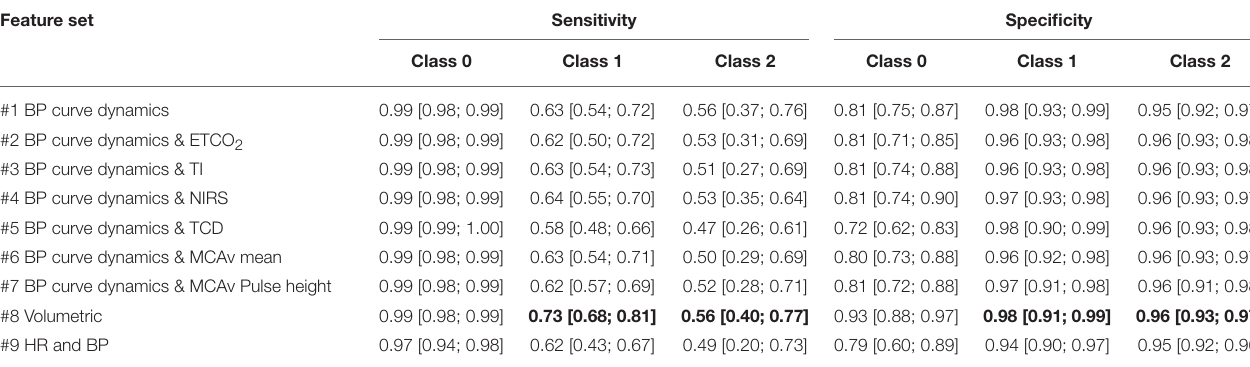
TABLE 3 | Median [25% 75%] sensitivity and specificity for different features sets for the three designated classes. Feature